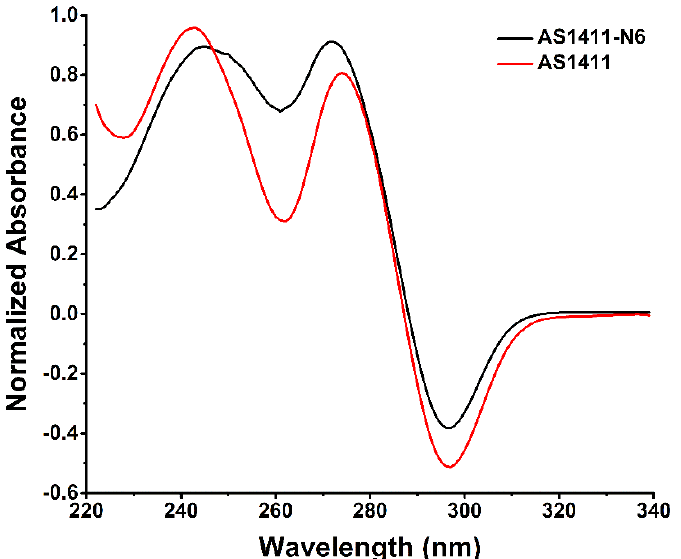
Figure 4. TDS spectra of AS1411-N6 and AS1411, performed in 10 mM of lithium cacodylate supplemented with 140 mM KCl. The graph was obtained by subtracting the spectrum at 25 °C from the spectrum at 90 °C, and then normalized relative to the maximum absorbance.